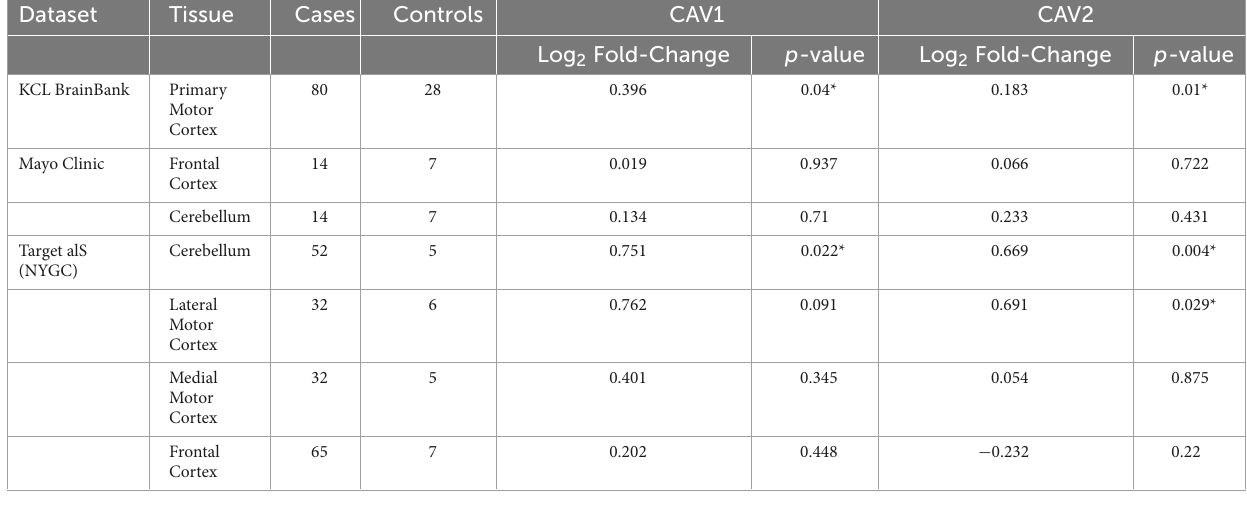
TABLE 1 The table outlines the differential expression (Log 2 -fold change) for CAV1 (blue) and CAV2 (green) across brain tissues and datasets, * p < 0.05.